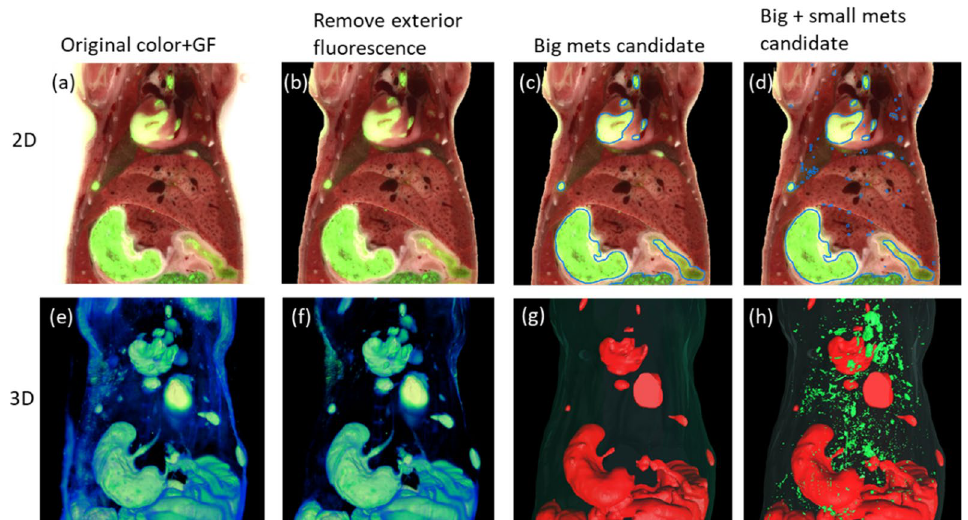
Figure 5. Workflow and results of metastases candidates segmentation. The first and second row shows 2D images and 3D rendering, respectively, in the abdominal region. The fused color and GF image and the 3D volume rendering of GF image are shown in ( a ) and ( e ), respectively. 2D and 3D results after exclusion of exterior fluorescence are shown in ( b ) and ( f ), respectively. 2D contouring and 3D surface rendering of the watershed segmented big metastases candidates are shown in ( c ) and ( g ), respectively. 2D contouring and 3D surface rendering of segmentation of small metastases candidates are shown in ( d ) and ( h ), respectively. There are a lot of FPs from auto-fluorescent structures such as spine, bile duct, lung vessels and airways etc. The segmentation results are input to the CNN classification